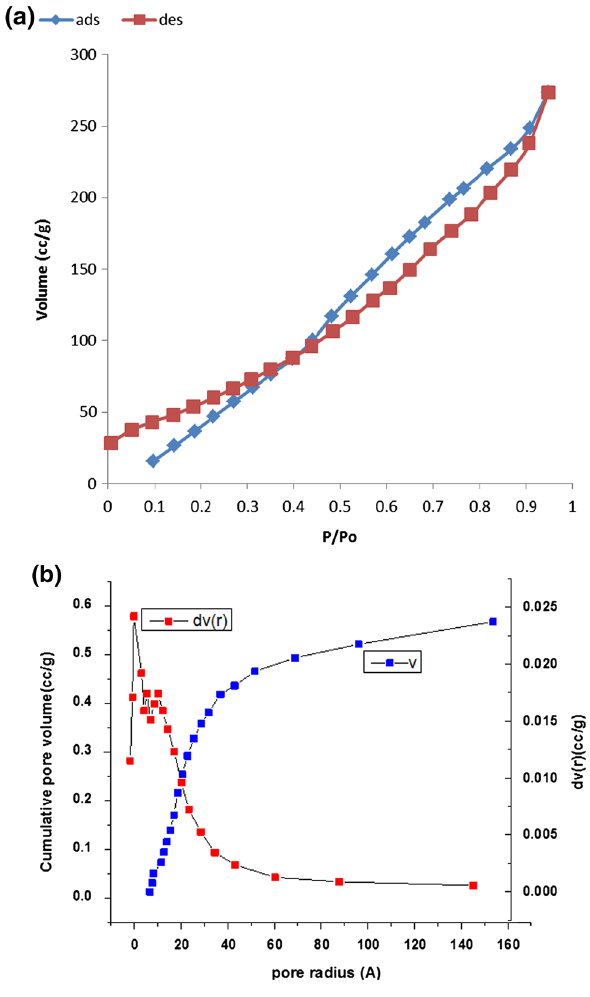
Fig. 4 Nitrogen adsorption isotherm of PACW at 77 K ( a ), and pore size distribution of PACW by BJH method desorption dV(r) ( b )